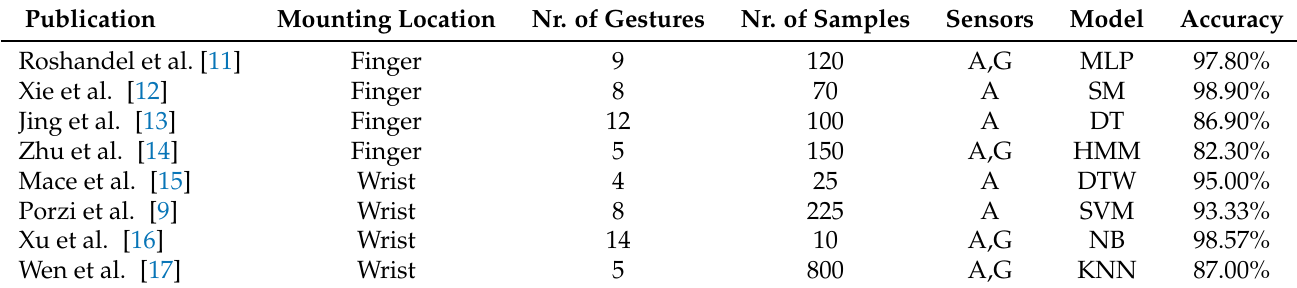
Table 1. Overview of the compared